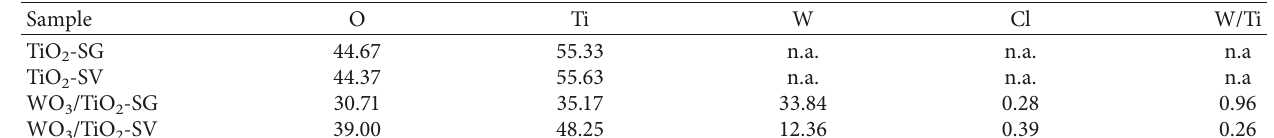
Table 2: Elemental compositions (wt.%) on external surface of catalysts obtained from EDX.